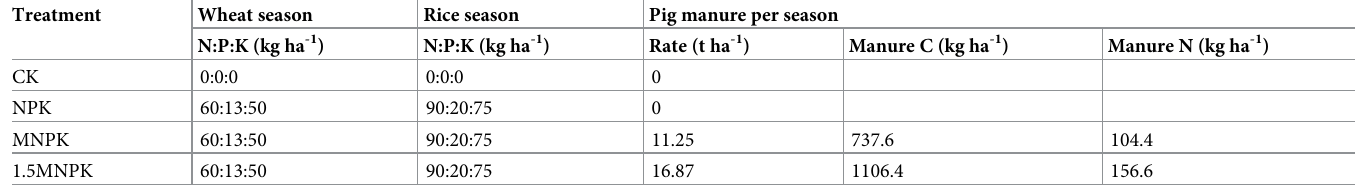
Table 1. Fertilizer rates in control (CK), chemical fertilizer (NPK), and the combination of manure and chemical fertilizer (MNPK, 1.5MNPK) treatments for each crop. Treatment Wheat